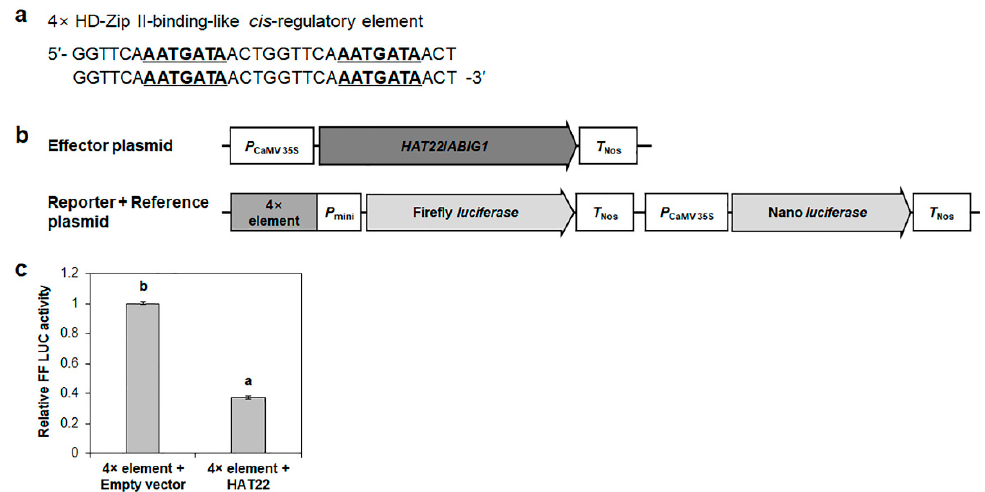
Figure 9. Transrepression assay for HAT22/ABIG1 via HD-Zip II-binding-like cis -regulatory element. ( a ) Sequences of tandem repeats of HD-Zip II-binding-like cis -regulatory element for transrepression assay. Consensus sequences are underlined. ( b ) Schematic maps of effector and reporter+reference plasmids for the transrepression assay. ( c ) The relative firefly luciferase activity in Arabidopsis protoplasts. The transformation efficiency was normalized using Nano luciferase activity. The normalized firefly luciferase activity of negative control was set as 1. The empty effector plasmid was used for the negative control. Data are shown as means ± S.D. ( n = 5). Different letters display significant differences ( p < 0.05).